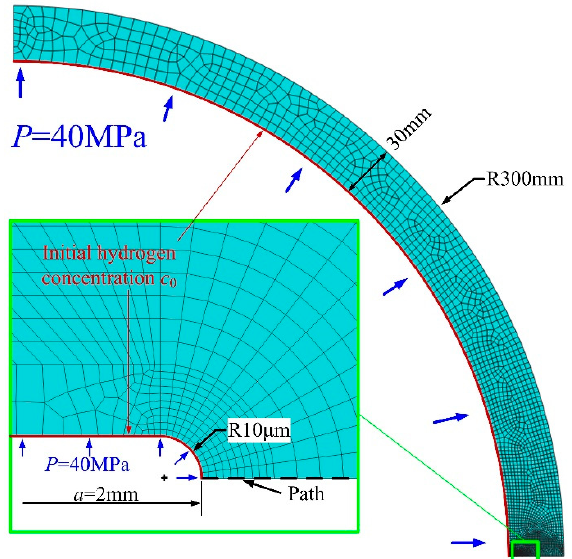
Figure 1. Mesh model and boundary conditions for the crack tip.